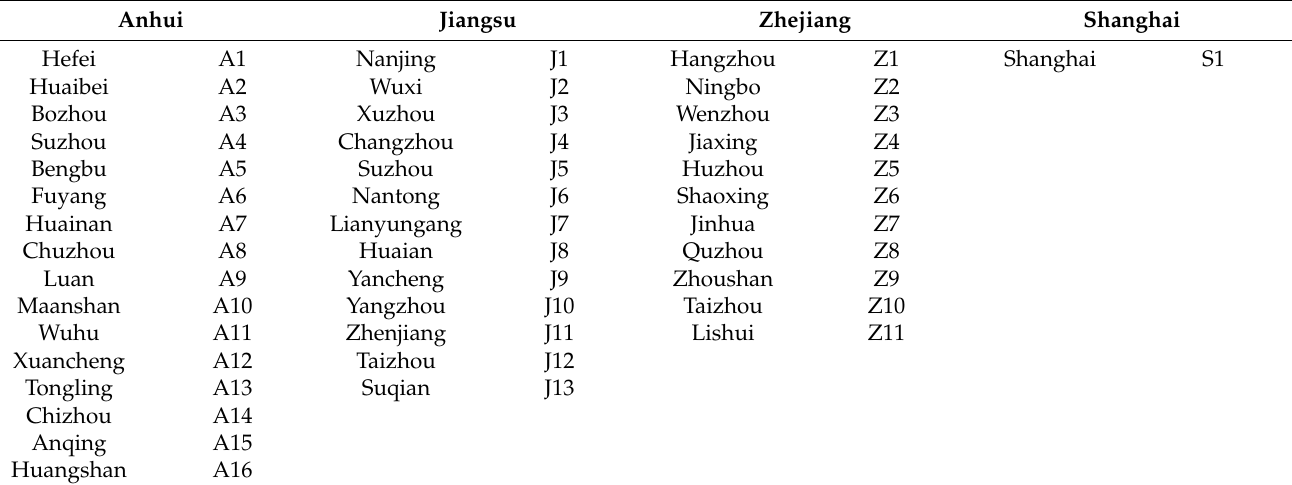
Table 1. City codes in the YRD